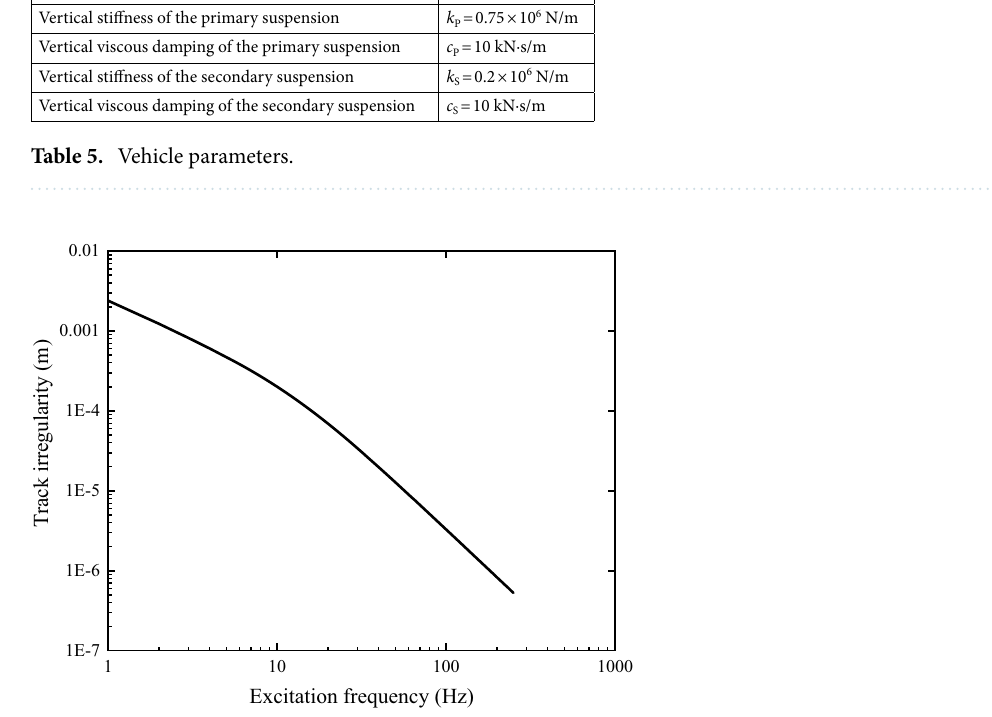
Figure 16. Track irregularity in the frequency domain (train speed: 100